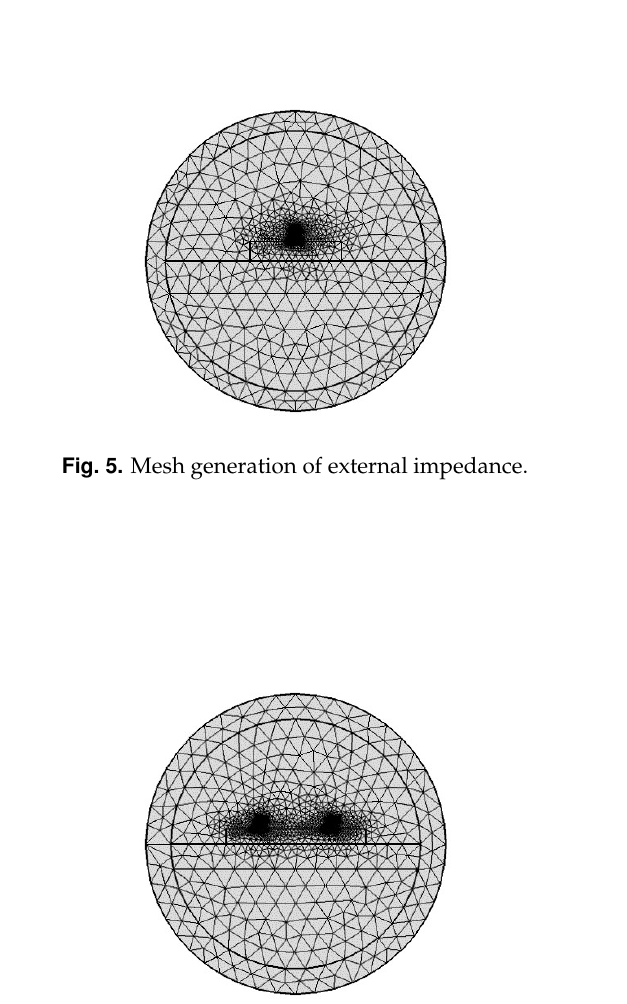
Fig. 6. Mesh generation of mutual impedance.